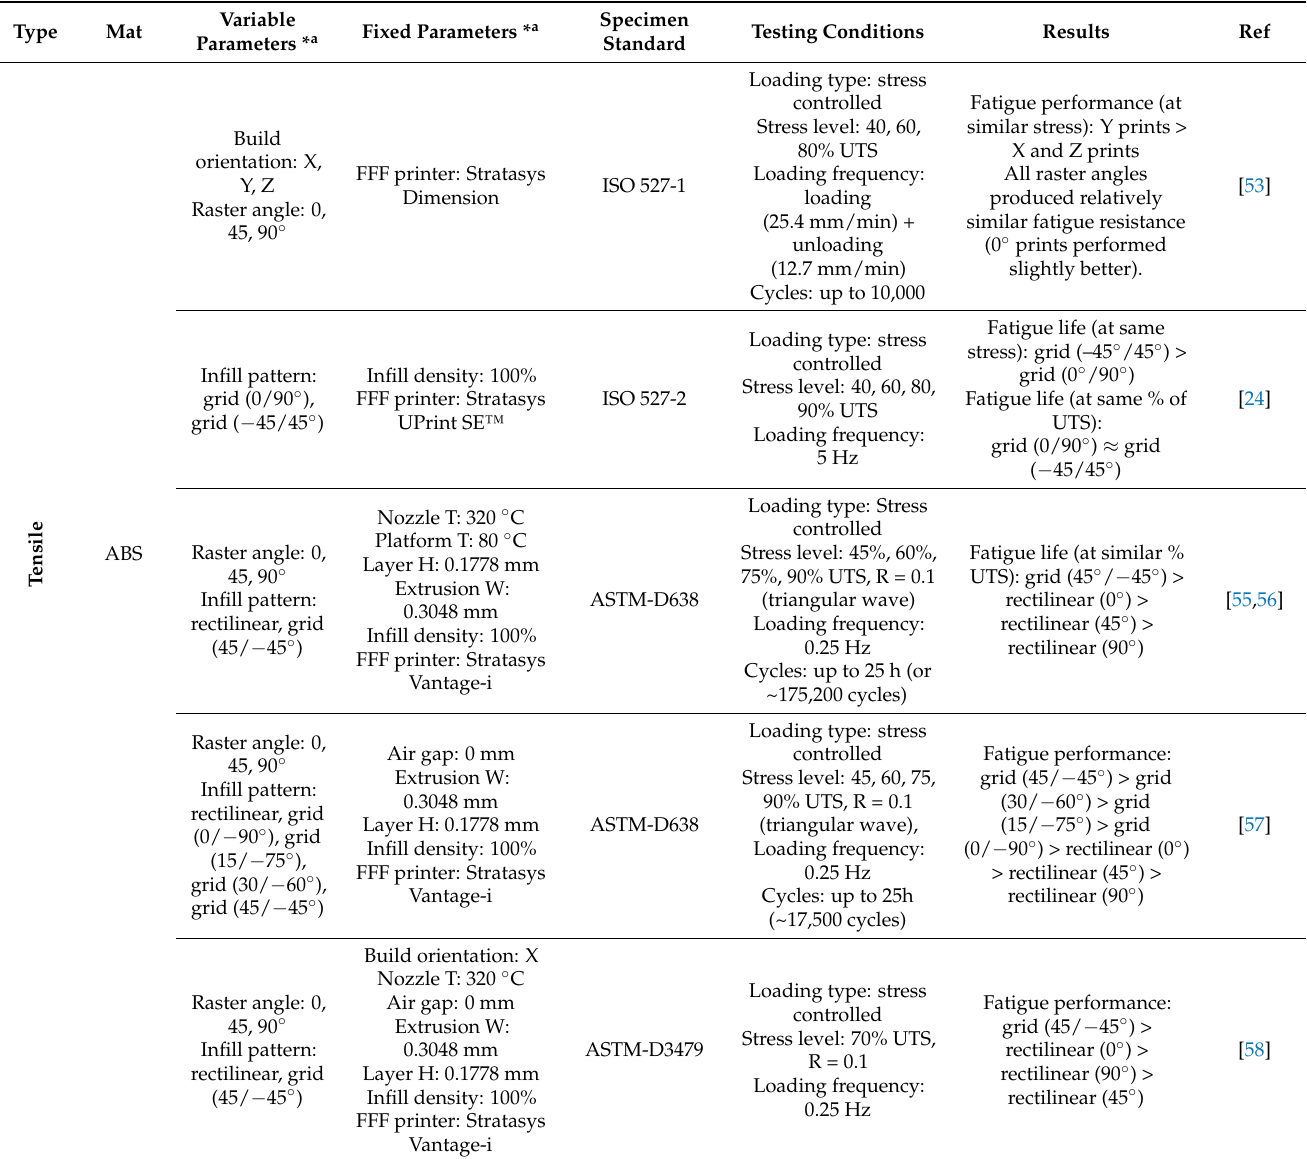
Table 2. Review of the parametric studies carried out on the influence of 3D printing parameters on the fatigue performance of FFF